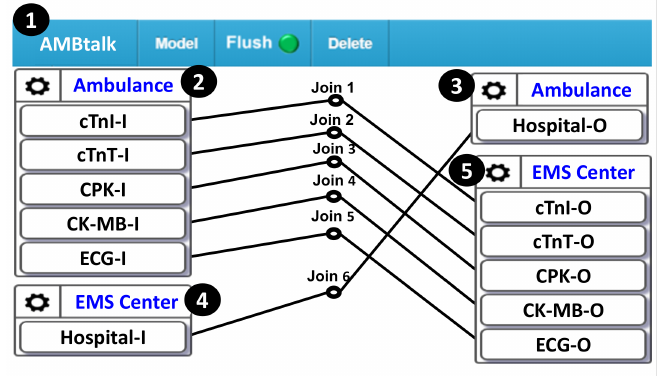
Figure 5. The AMBtalk graphical user